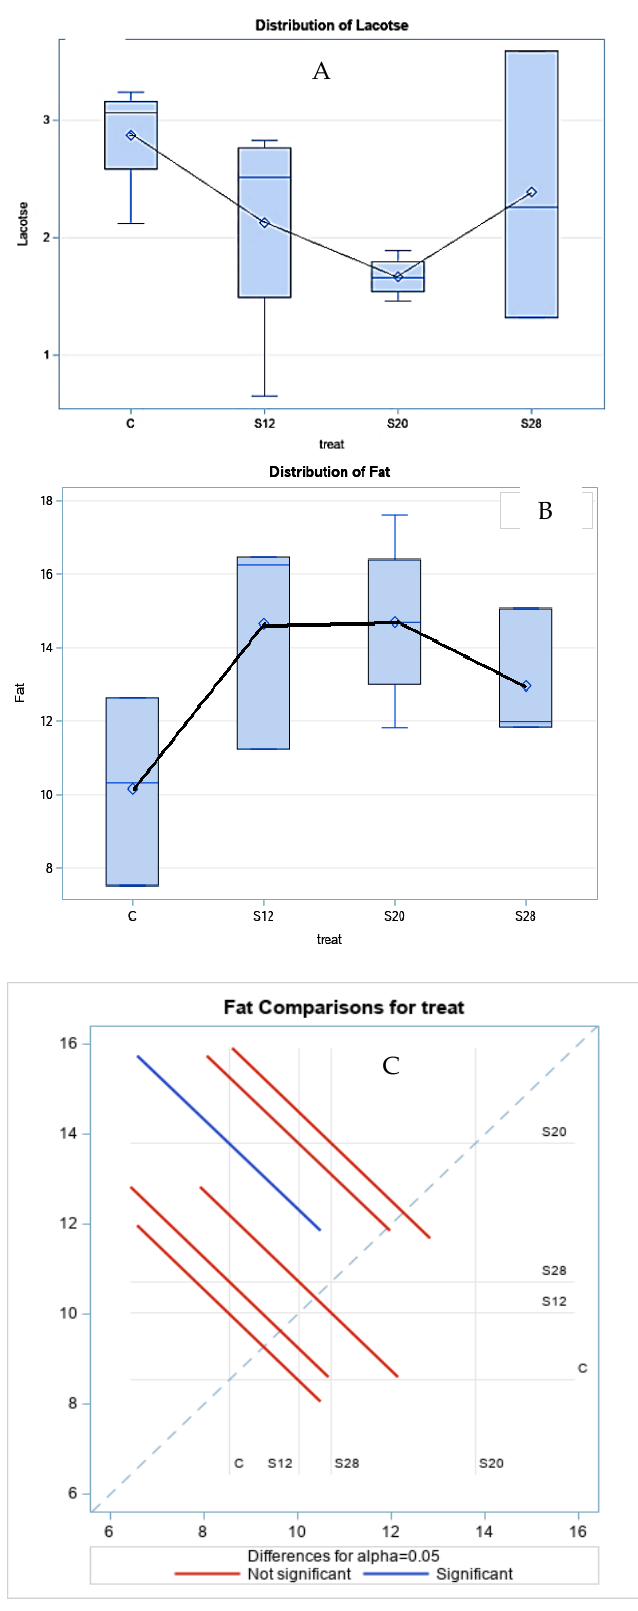
Figure 2. The effect of different levels of sunflower hulls on the colostrum composition at 3 h postpartum, as assessed via the regression analysis ( A ), Lactose distribution; ( B ), Fat distribution; ( C ) Fat comparisons for treatment.